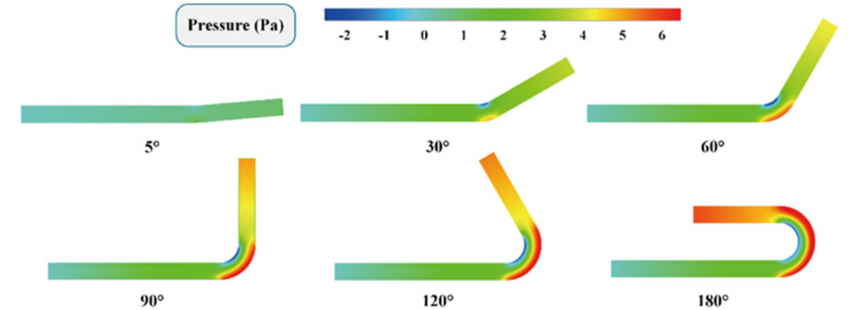
Figure 4. Pressure distribution of bend pipe with different bending